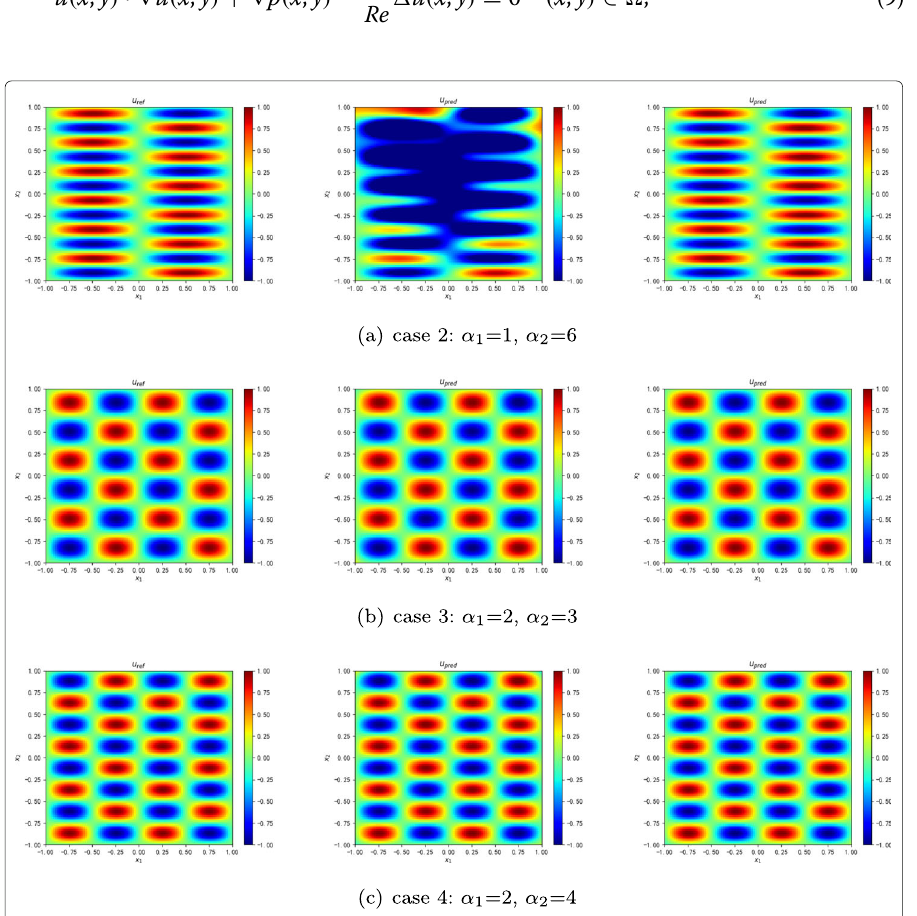
Fig. 3 Prediction results of PINN-anneal on Helmholtz benchmarks (case 2-4). Left : reference solution. Middle : predicted solution using random initialization. Right : predicted solution using transfer